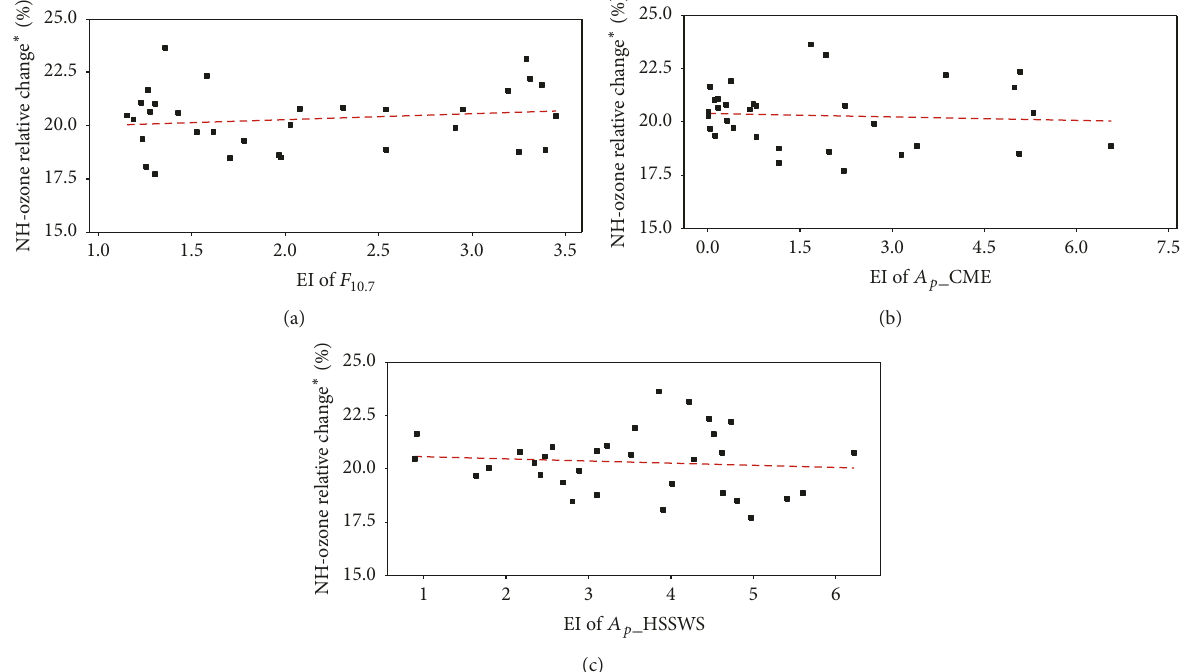
Figure 5: As Figure 3, but for the northern polar ozone (after detrending EESC effects). NH- 𝑂 ∗ var denotes that the ozone data of NH has detrended the EESC